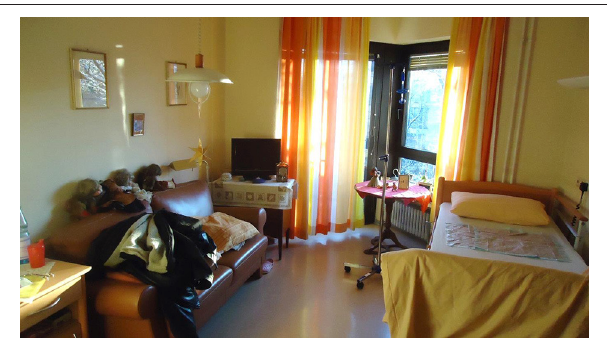
FIGURE 1 | Private room of a resident of a nursing home, taken by Artner